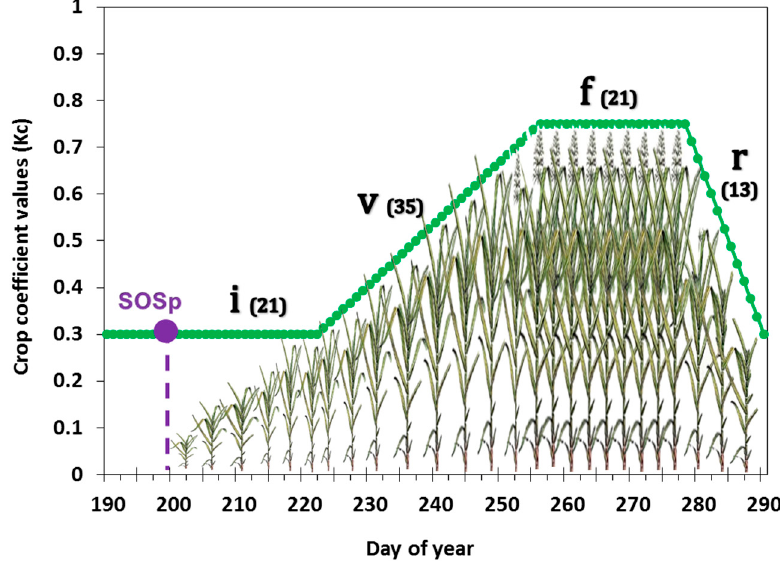
Figure 3. Overall crop coefficient curve for Senegal’s Sahelian rangelands during a growing season of 90 days. The growing period was divided into four phases: initial ( i ); vegetative ( v ); flowering ( f ); ripening ( r ). SOSp indicates the mean date of the onset of the rainy season in the 2000-2015 period. Numbers in brackets indicate the total days of the phase.